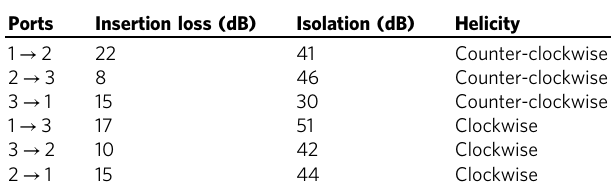
Table 1 Circulation insertion loss and isolation for counter- clockwise and clockwise